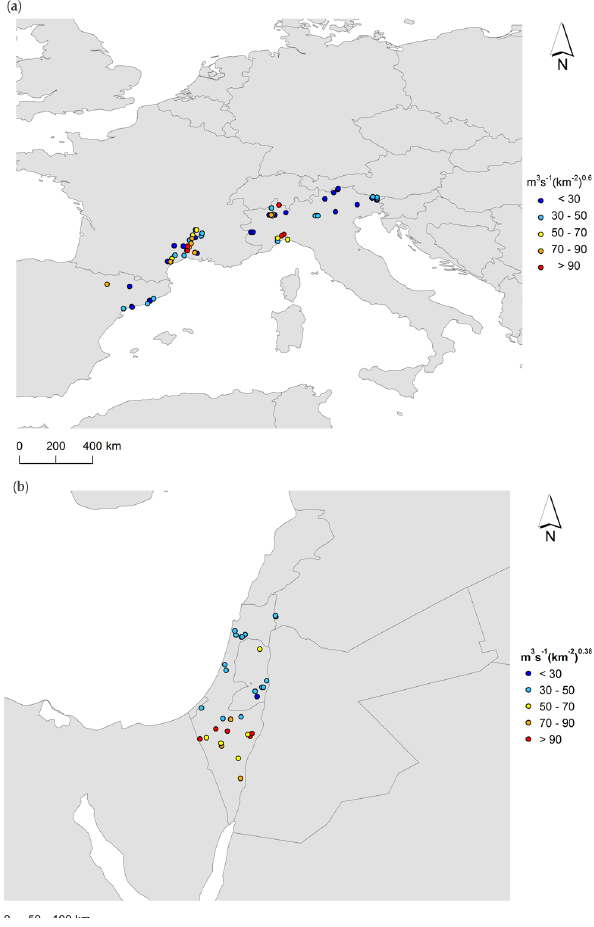
Fig. 2. Atlas of reduced peak discharge Q u of extreme flash floods in the two Mediterranean regions: (a) Western Region (Spain, France, Italy); (b) Eastern Region (Israel).